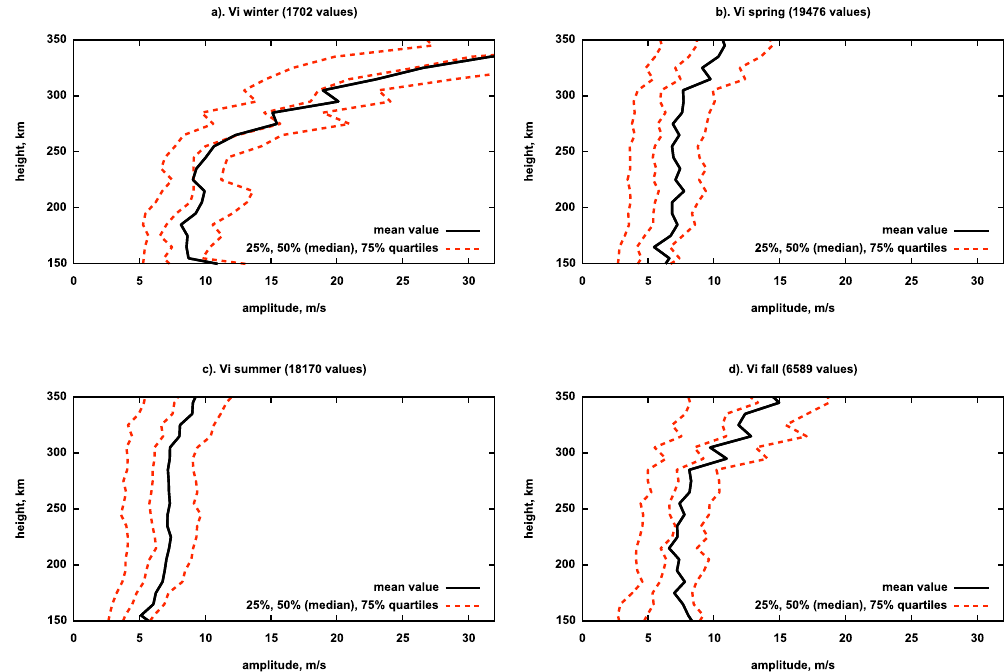
Fig. 17. Amplitude variations as function of altitude as observed in ion velocity data during the different seasons. The black curve shows the average. The middle half of observed amplitudes is within the leftmost and rightmost red dashed lines (the dashed line in the middle is the median value). The number of datapoints given in the titles of the plots is the sum of points from all altitude